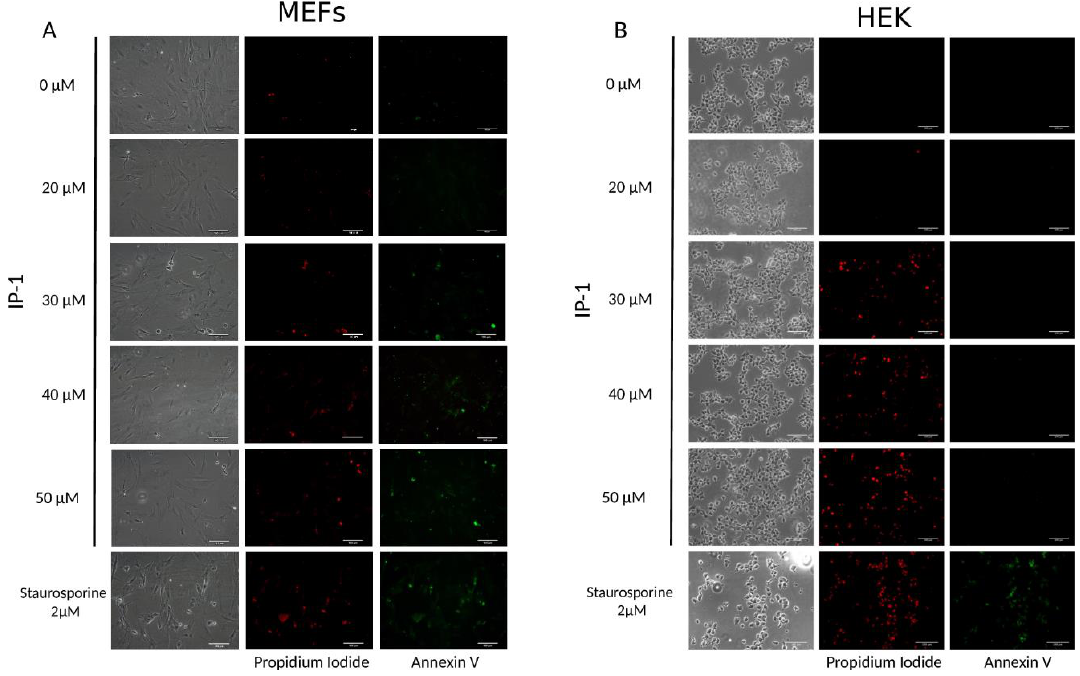
Figure 2. IP-1 induces apoptosis at low doses in MEF cells and necrosis at higher doses in HEK293T cells. MEF ( A ) and HEK293T ( B ) cells were treated with IP-1 at the indicated concentrations or with 2 μM Staurosporine for 2h as positive control. Then, the cells were stained with Annexin V-FITC in order to detect PS exposed to the outer layer of the cell membrane, an event related to apoptosis induction. Additionally, cells that have lost membrane integrity also incorporate propidium iodide, showing red fluorescent staining. As shown in ( A ), starting at 30 μM of IP-1, MEF cells present Annexin V or propidium iodide staining, unlike to HEK293T cells that only incorporated propidium iodide. Experiments were conducted twice; the images are representative. Scale bar represents 100 µ